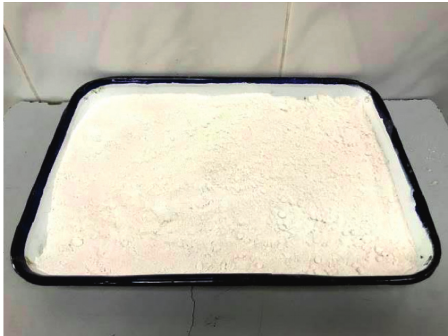
Figure 2: The lime used in this study.